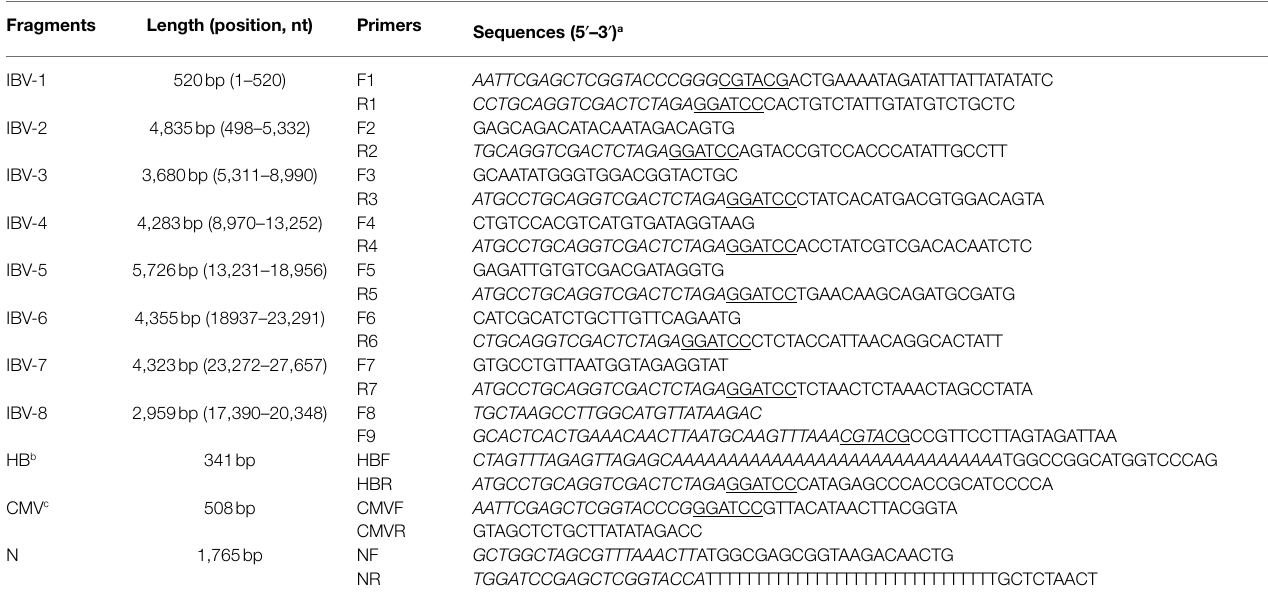
TABLE 1 | Primers used in this